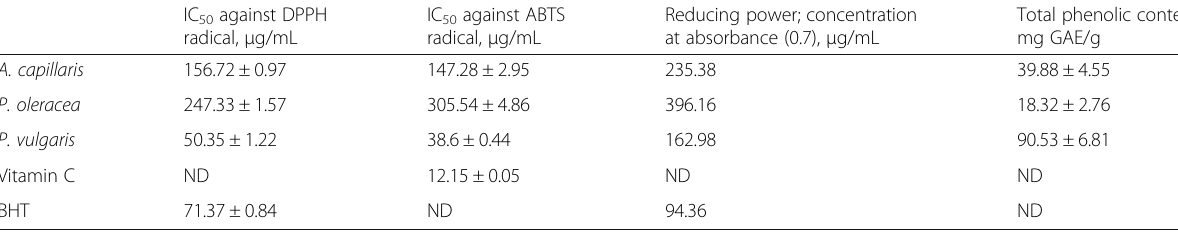
Table 1 Antioxidant activity of A. capillaris , P. oleracea , and P. vulgaris extracts IC 50 against DPPH radical, μ